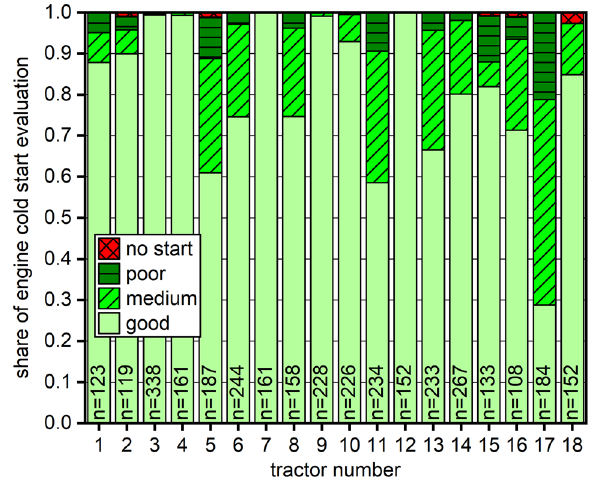
Fig. 2 Evaluation of engine cold start in the years 2015 to 2017 for the 18 tractors ( n : number of documented cold